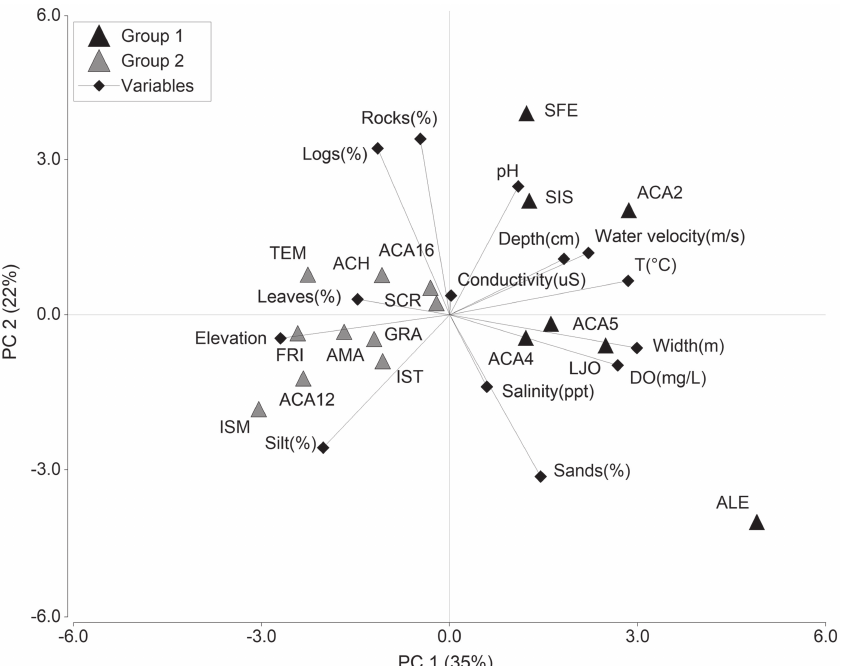
Fig. 3. Principal Component Analysis (PCA) of four physicochemical variables of the water, eight variables of habitat structure and 17 sampling sites. Localities separated by the two groups identified by CCA in the Río Acahuapa basin, San Vicente, El Salvador, 2011-2012.